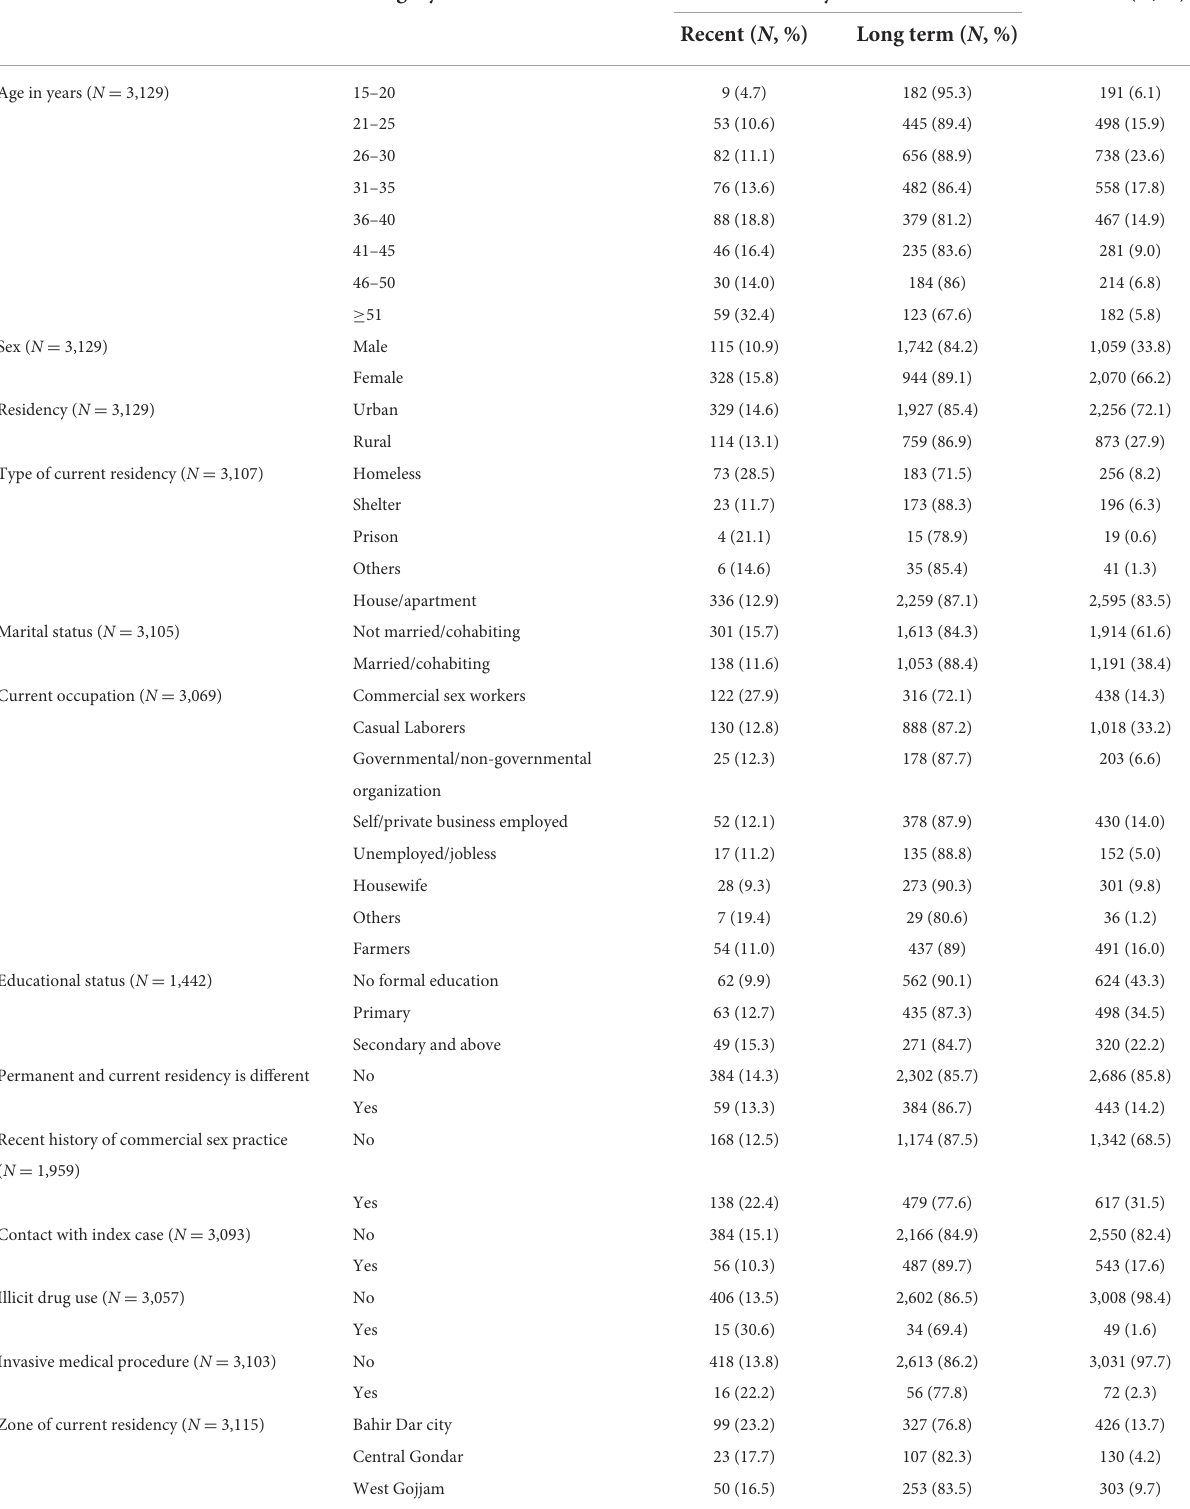
TABLE 1 Socio-demographic characteristics of recently infected HIV clients in the Amhara regional state, northern Ethiopia, 2021 ( N = 3,129).